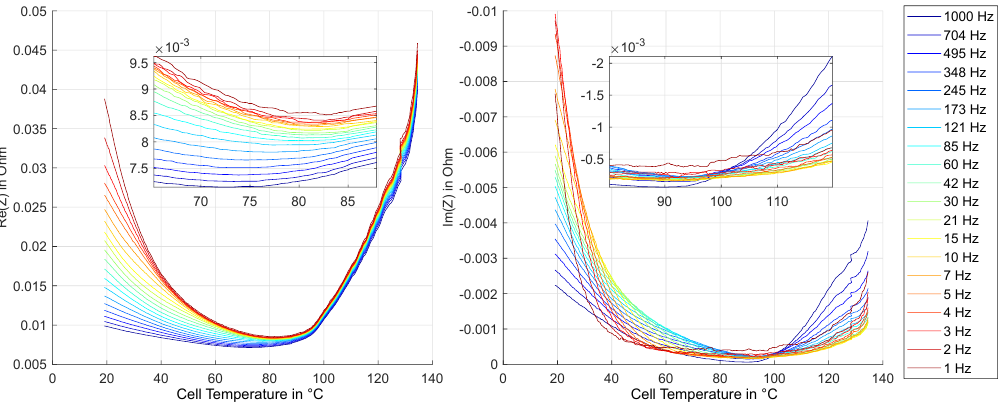
Figure 11. Experiment HT1: Real and imaginary part of impedance at different frequencies over